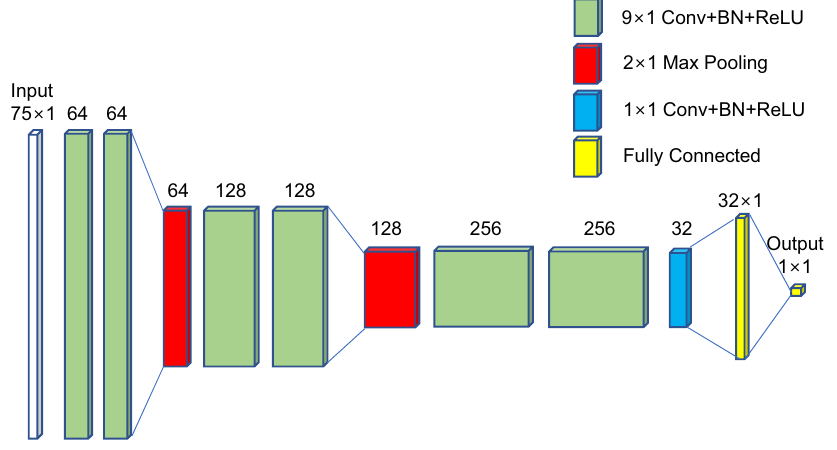
Figure 8. Proposed structure of the surface temperature-deep convolutional neural network